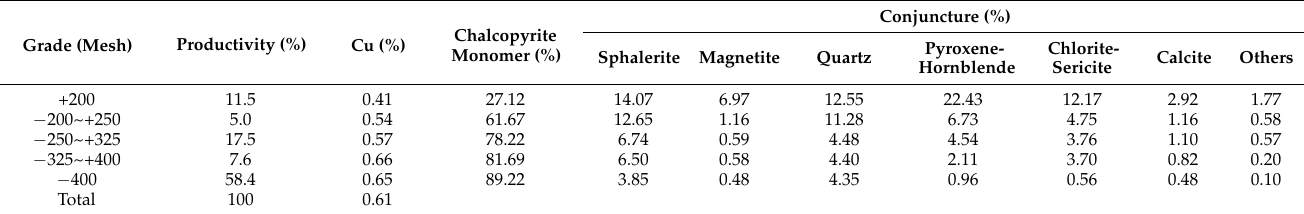
Table 6. Monomer dissociation of chalcopyrite in each size